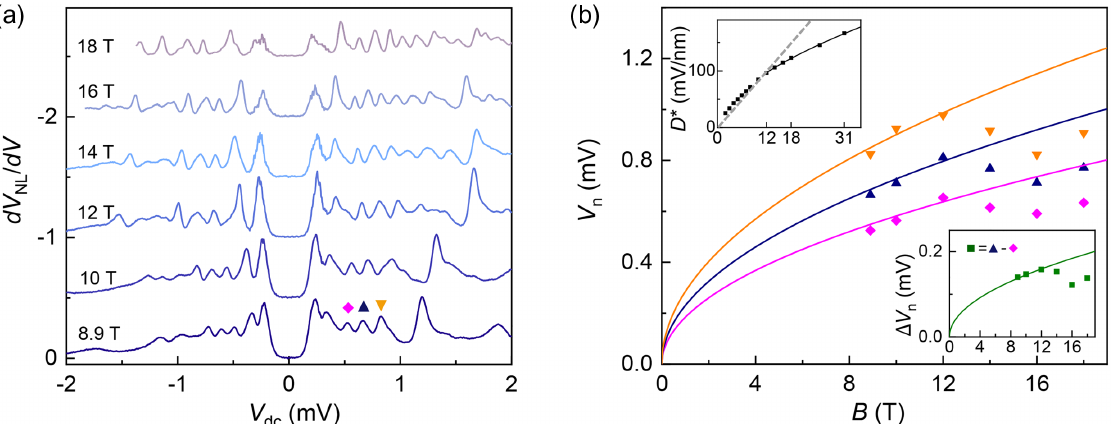
=dV at selected magnetic field from 8.9 to 18 T obtained in the NL . Solid lines in both plots show n